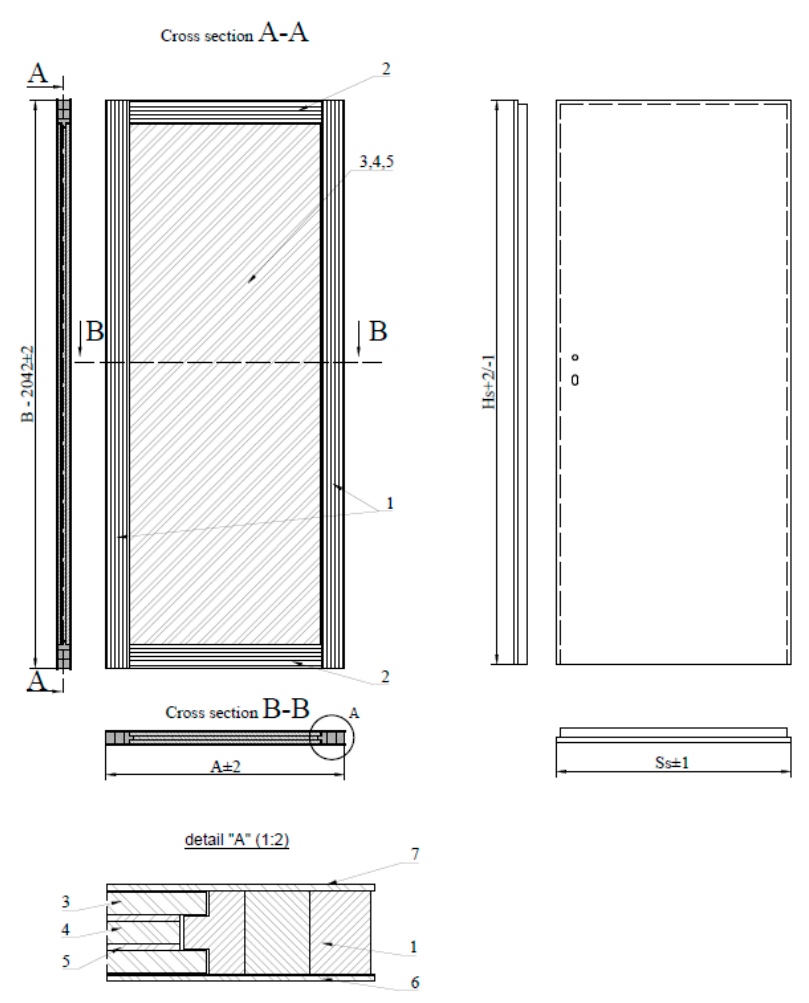
Figure 3. Door construction 1.